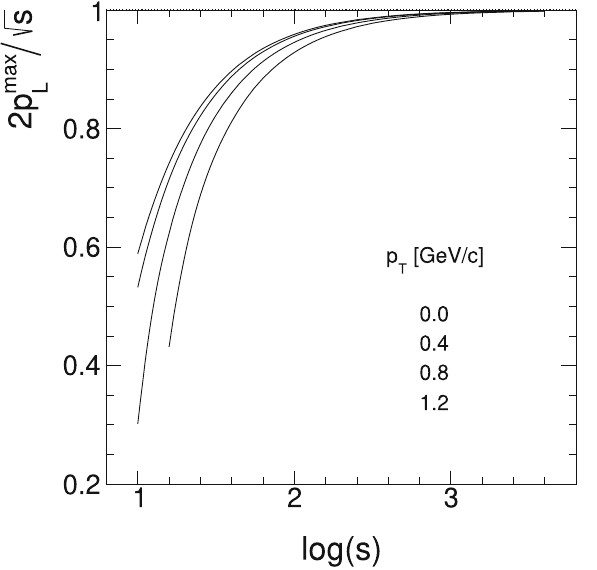
Fig. 115 Theratio x (cid:3) / x F asafunctionoflog ( s ) fordifferent p T values F